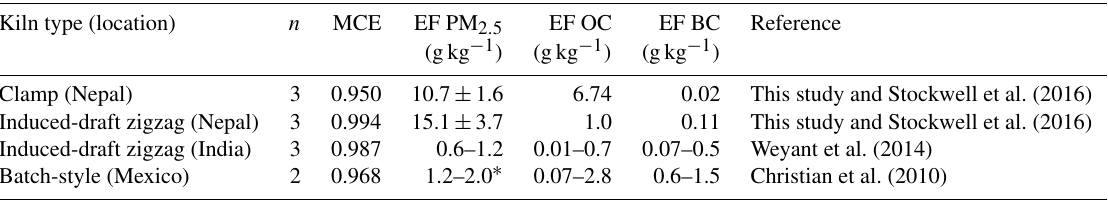
Table 5. Comparison of brick kiln emissions of PM 2 . 5 , OC, and BC in this study to prior studies of similar kiln design. Kiln type (location) n MCE EF PM 2 . 5 EF OC EF BC Clamp